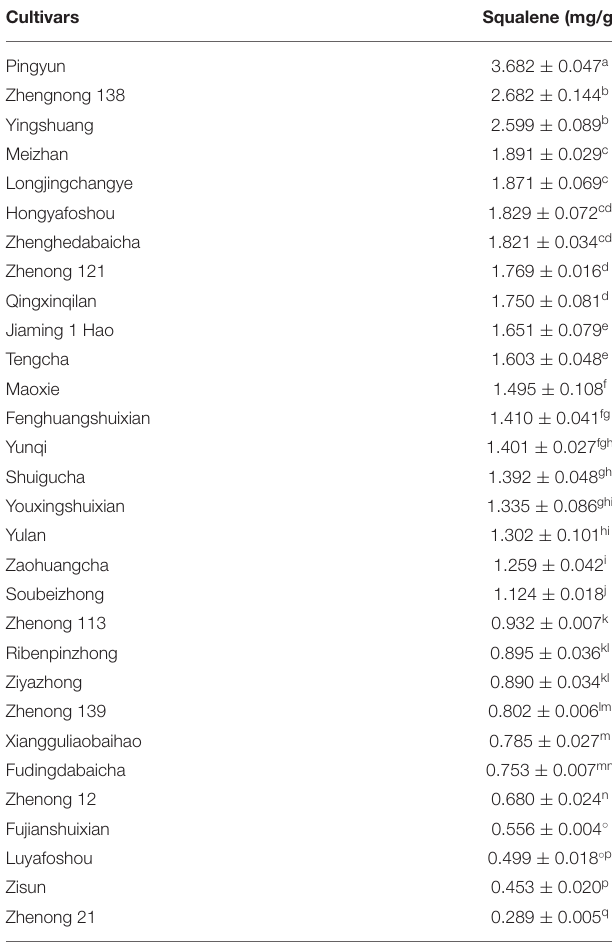
TABLE 7 | Squalene content of various tea cultivars*.